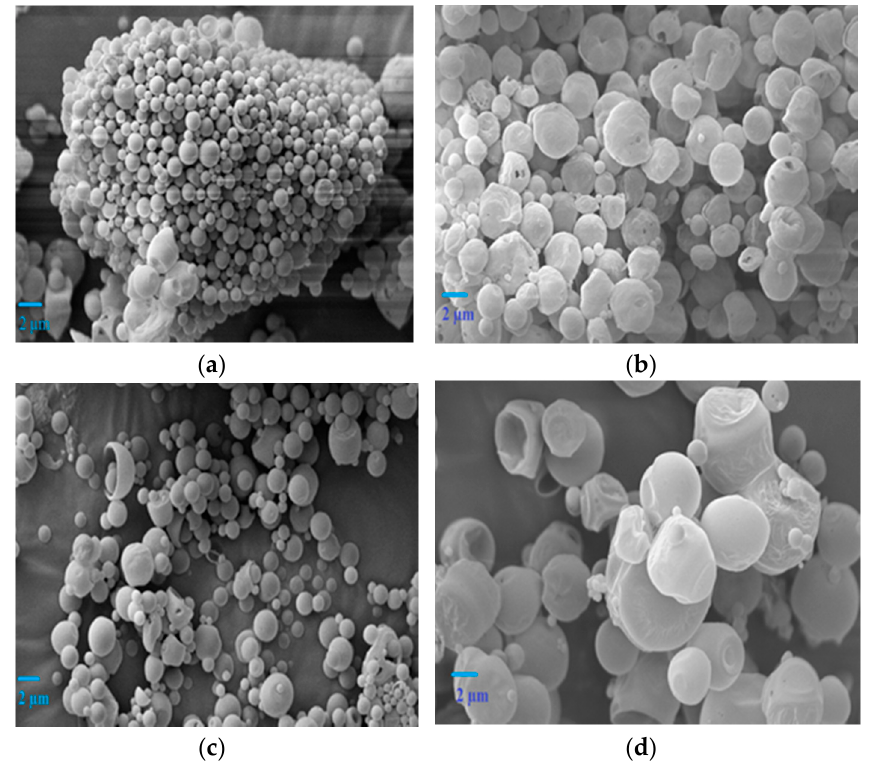
Figure 1. Scanning electron microscope (SEM) images of lysozyme loaded double-walled microspheres prepared in different formulations. ( a ) LF1; ( b ) LF2; ( c ) LF3; and, ( d ) LF4.